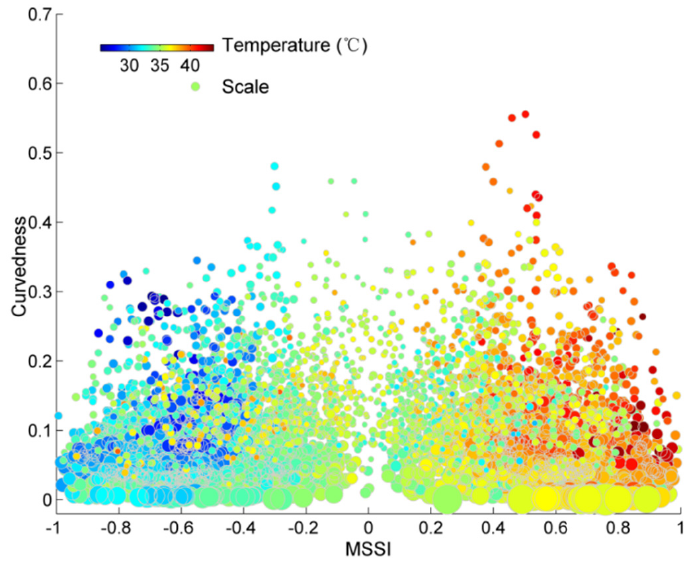
Figure 6. The relationships among the MSSI, curvedness, scale and temperature.